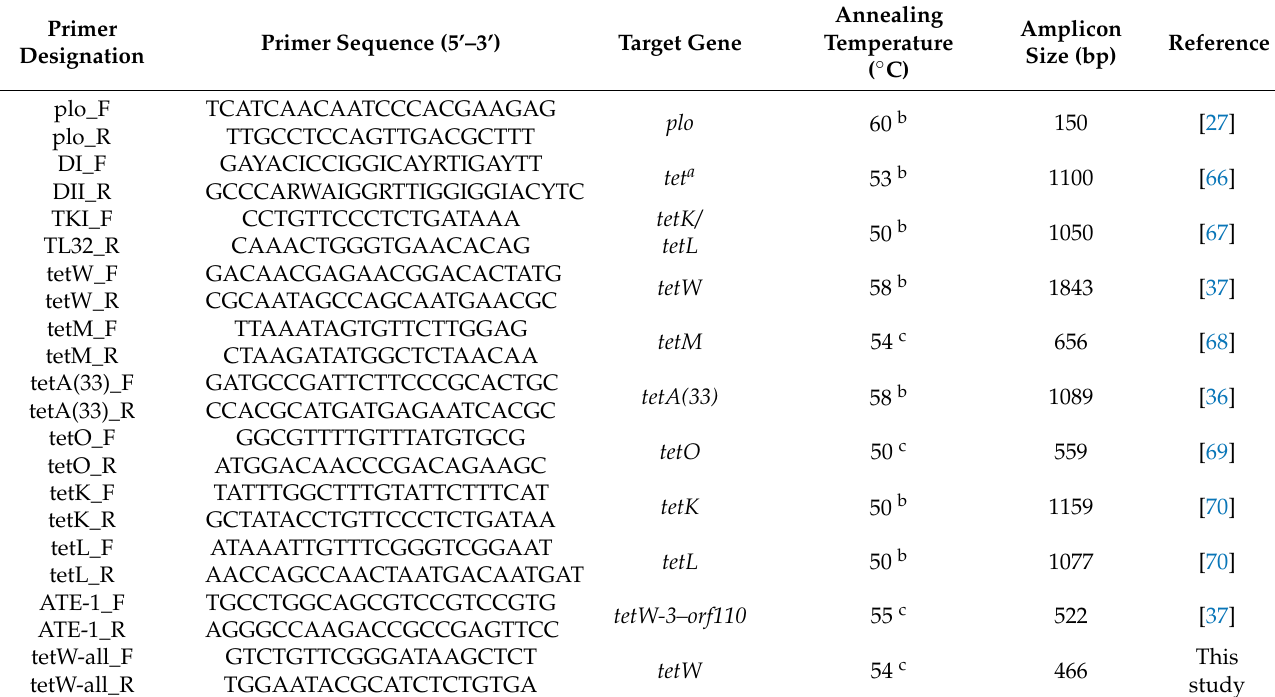
Table 3. Primers and PCR conditions used in this